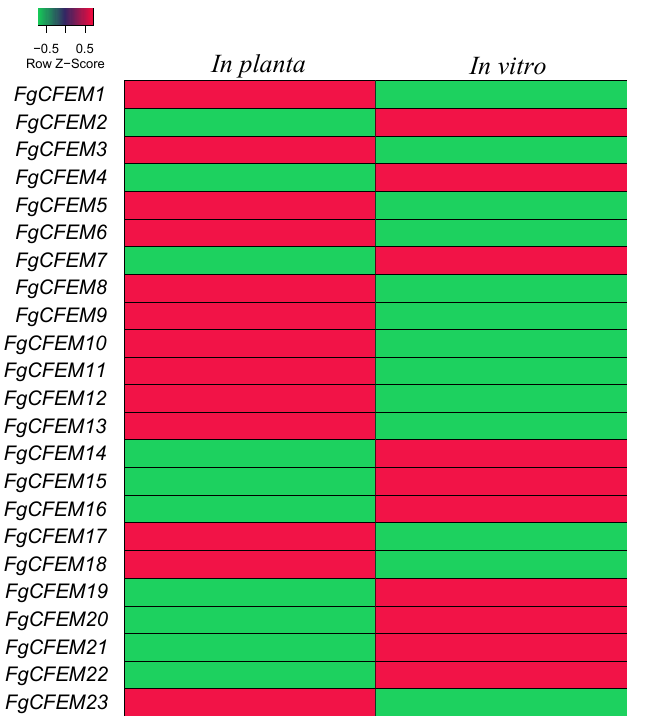
Figure 6. The heat map of FgCFEM genes. Green represents lower expression, red represents higher expression.